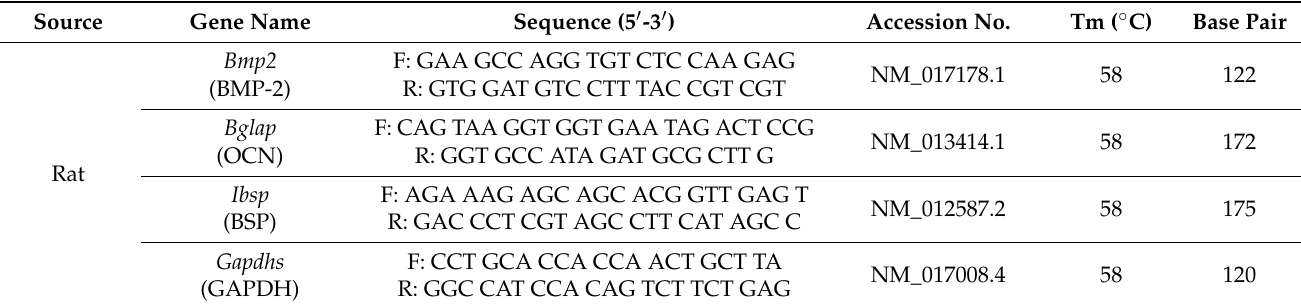
Table 2. Rat primer sequences used for